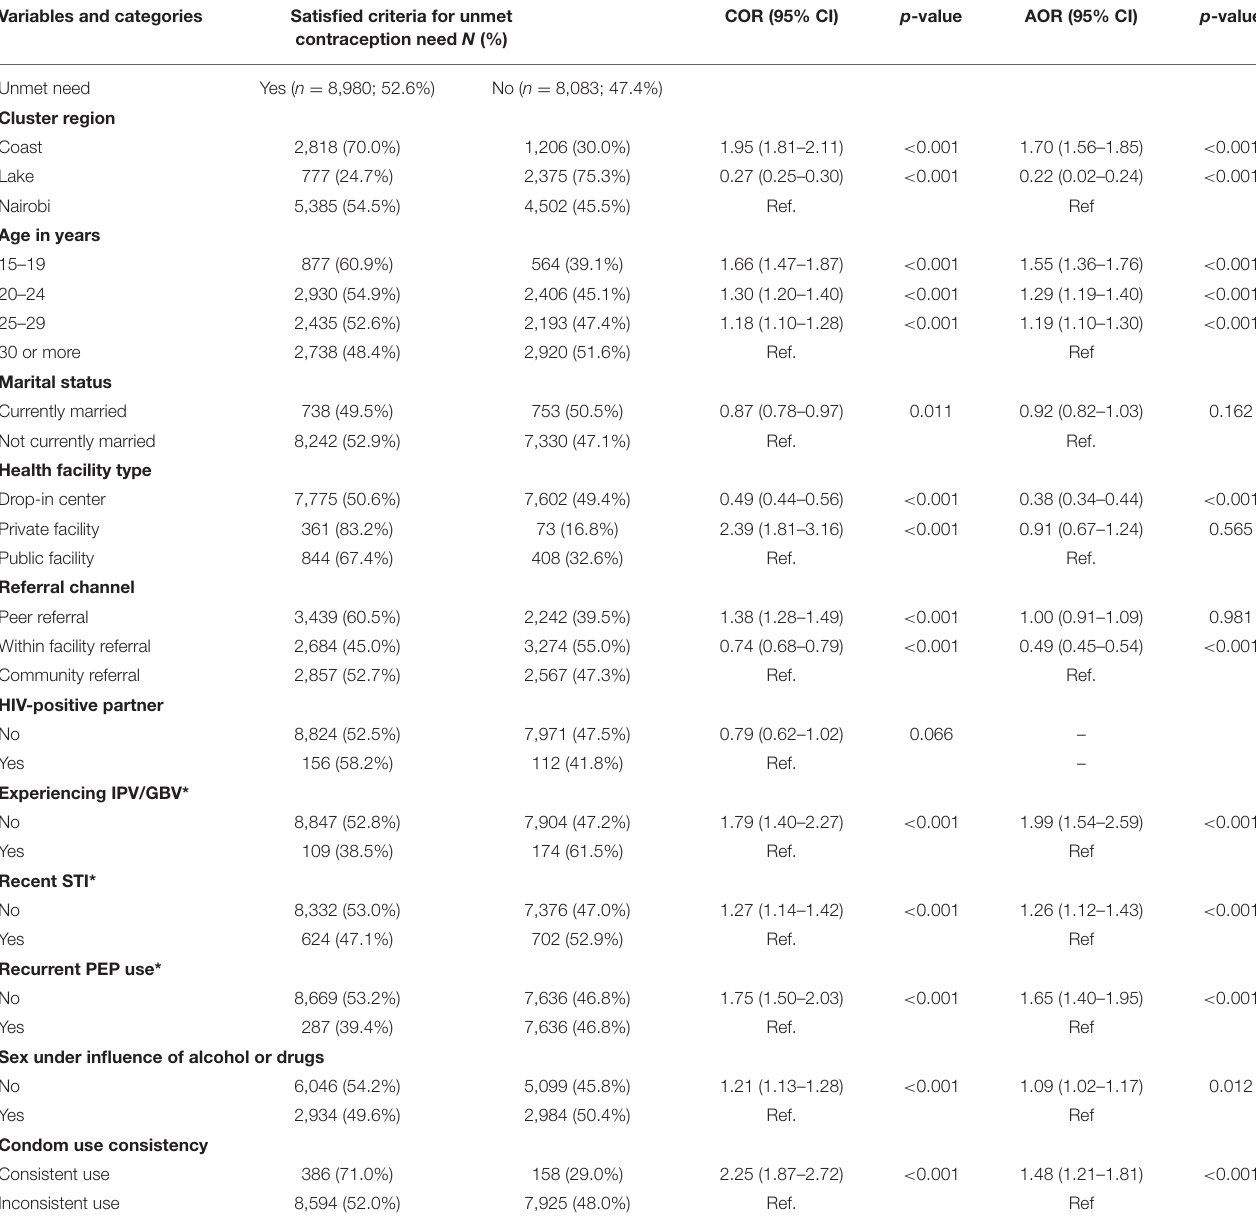
TABLE 1 | Associations between unmet contraception needs and independent variables at univariable and multivariable regression analysis. Variables and